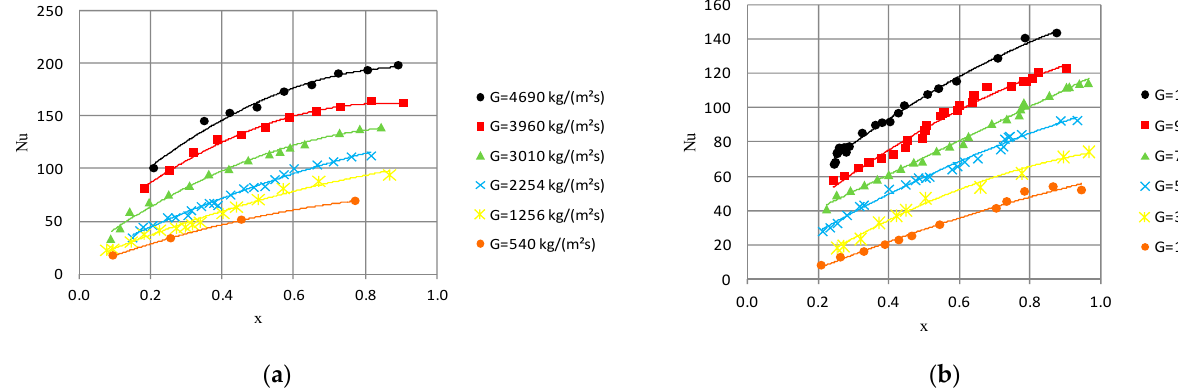
Figure 5. Dependence of heat transfer coefficient on average vapor quality α = f(x a ) during HFE 7000 condensation in minichannels with internal diameter: ( a ) d i = 1.2 mm, inlet T s = 39 °C; ( b ) d i = 2.5 mm, inlet T s = 42 °C.